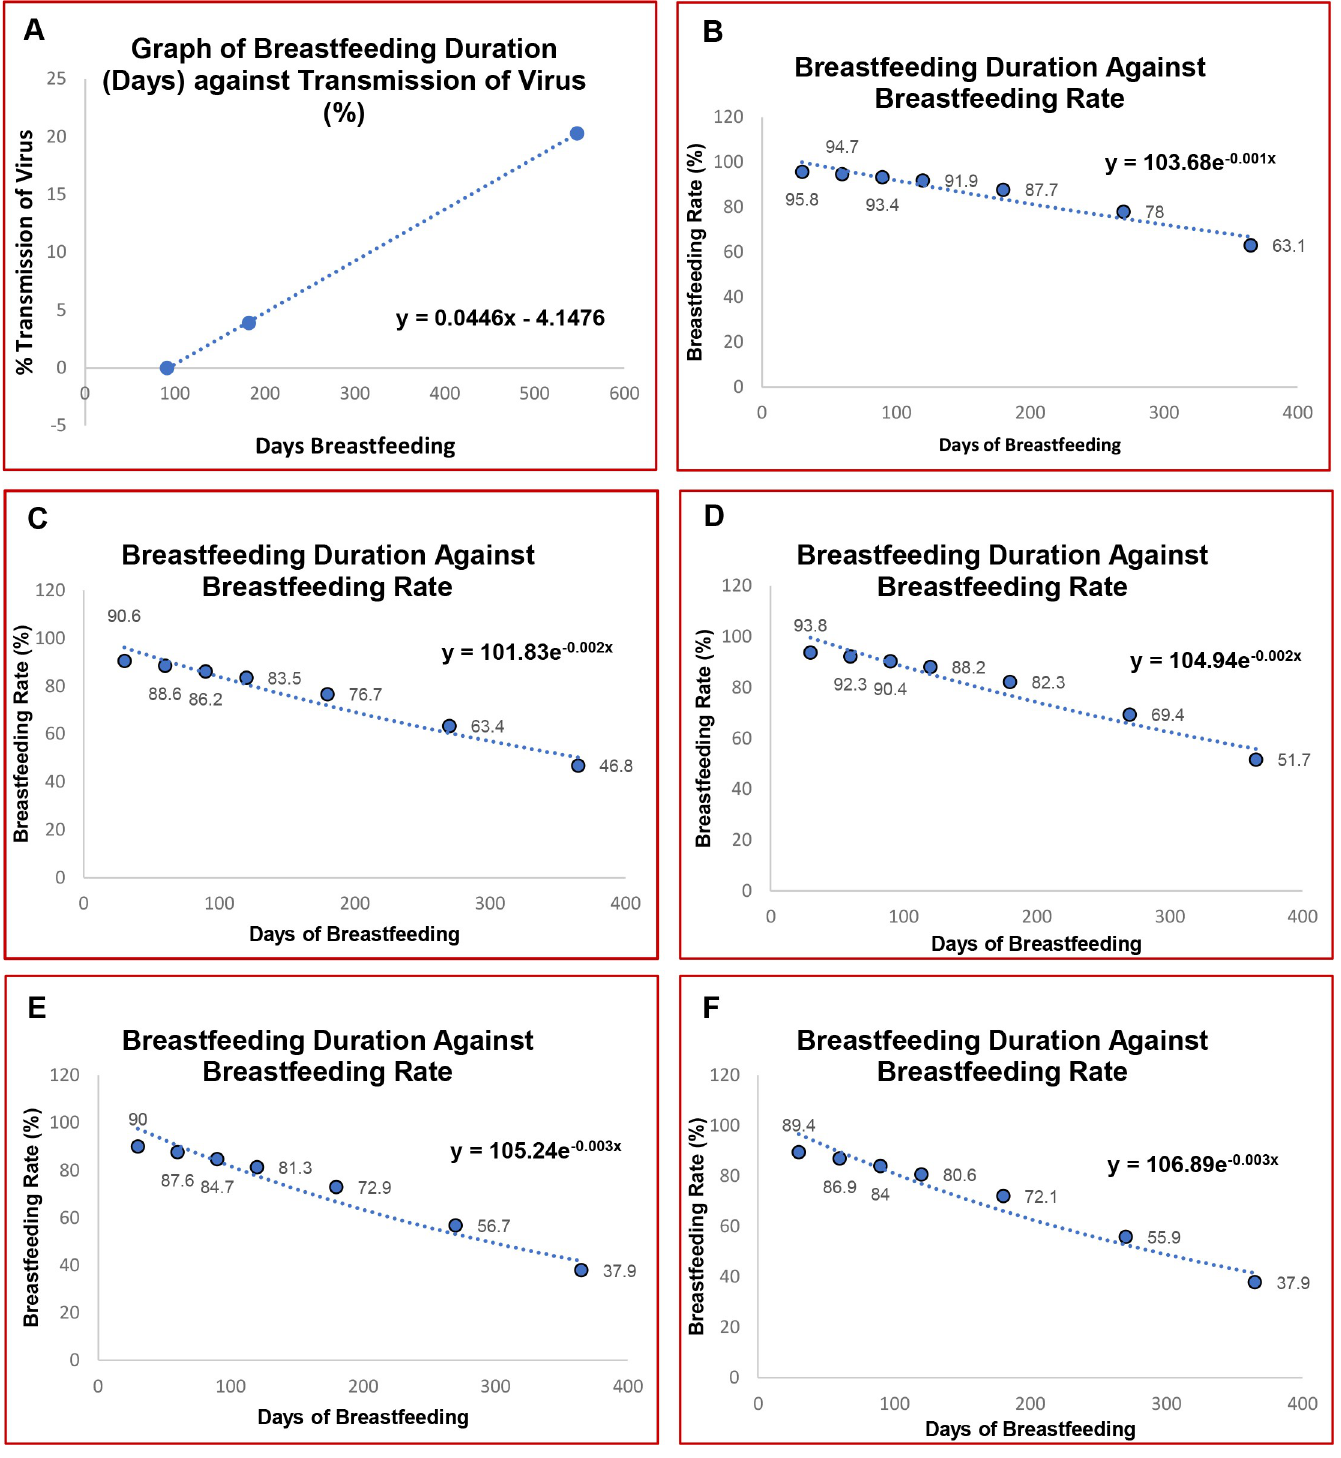
Fig 1. Estimation of HTLV-1 mother-to-child transmissions cases in Brazil. A) Model used to calculate the number of breastfeeding women over time in Brazil: Breastfeeding duration (days) against HTLV-1 transmission; B-F) Model used to evaluate the HTLV-1 transmission risk according to breastfeeding duration rates in the different Brazilian regions: B) North; C) North East; D) Midwest; E) South East; F) South.